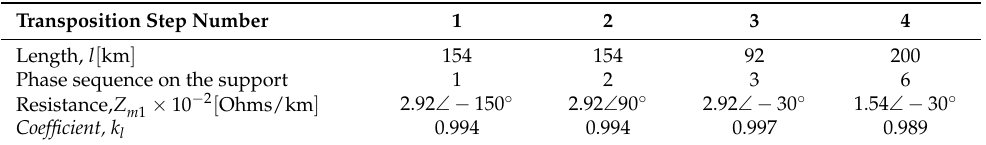
Table 5. The values of the line parameters at the lengths of the transposition steps selected according to the developed method. Equations (15) and